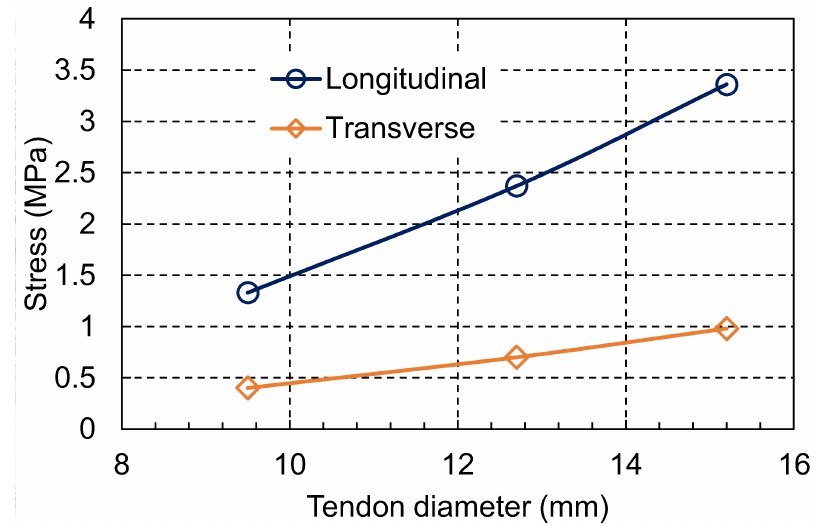
Figure 4. The effect of prestressed tendon diameter on the stress level in concrete